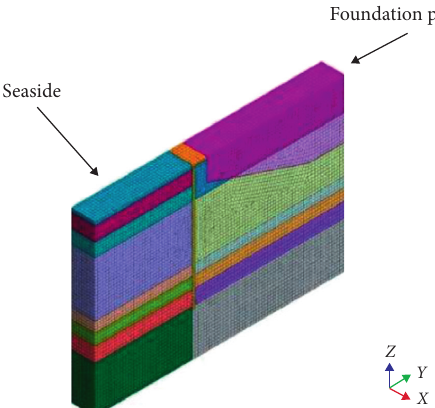
Figure 13: Profile of model for impact analysis of wave loads on the foundation pit.